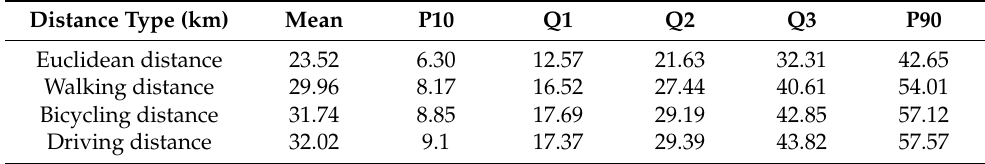
Table 2. Univariate statistics for the distances calculated between communities and parks. Distance Type (km)